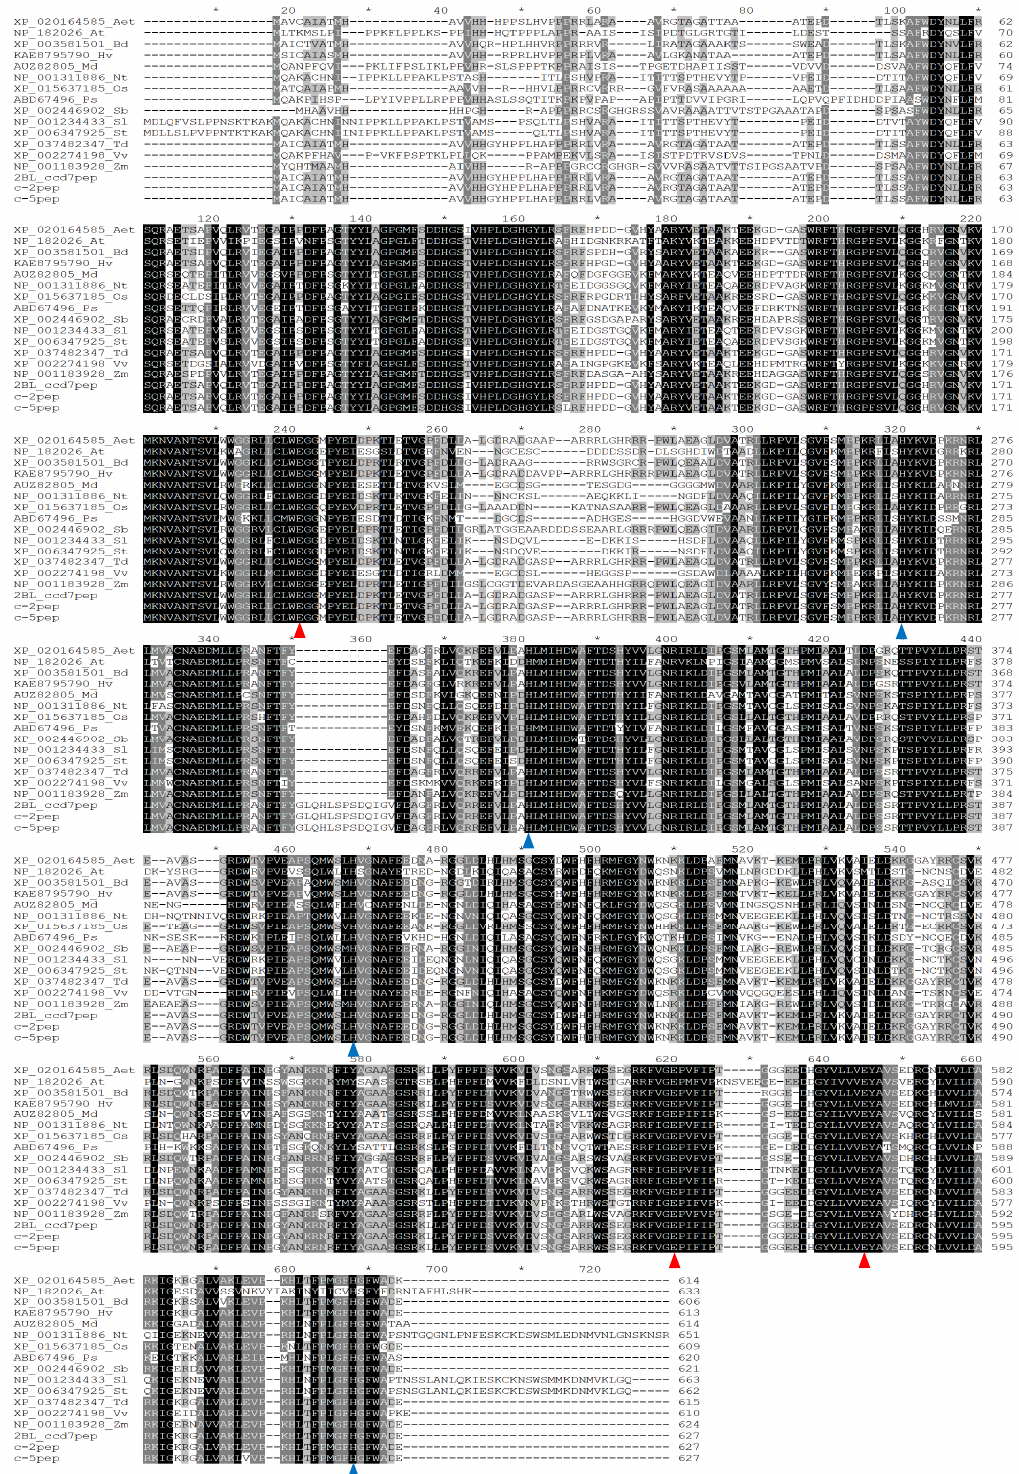
Figure 2. Multiple alignment of CCD7 proteins in different monocots and dicots. The names of CCD7 proteins are at the left and amino acid numbers are indicated at the right of the alignment. Red and blue triangles represent conserved iron ‐ binding Glu and His residues, respectively. Aet , Aegilops tauschii , At , Arabidopsis thaliana , Bd , Brachypodium distachyon , Hv , Hordeum vulgare , Md , Malus domestica , Nt , Nicotiana tabacum , Os , Oryza sativa , Ps , Pisum sativum , Sb , Sorghum bicolor , Sl , Solanum lycopersicum , St , Solanum tuberosum , Td , Triticum dicoccoides , Vv , Vitis vinifera , Zm , Zea